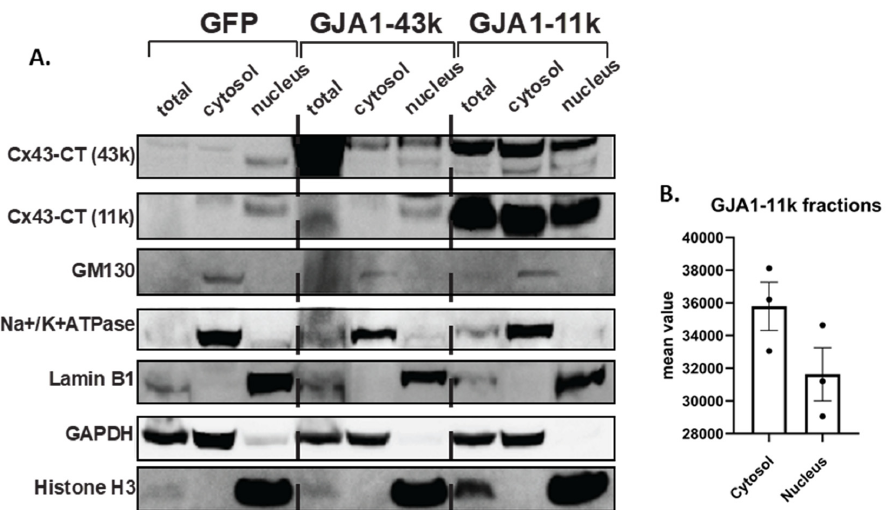
Figure 2. ( A ). Biochemical isolation of GJA1-11k in the nucleus. Western Blot of Cx43 isoforms in subcellular fractions (cytosolic and nuclear fractions) of HEK293FT cells over-expressing exogenous GJA1-11k, GJA1-43k, and GFP-V5 tagged plasmid cDNA, probed to monoclonal Cx43-CT (Millipore) antibodies. To demonstrate enriched biochemical isolation, the same blot was probed using antibodies to different subcellular fraction markers, including cytoplasmic (GAPDH), membrane (Na + /K + -ATPase), Golgi (GM-130), and nuclear markers (Histone H3, Lamin B1). The results are representative of three independent experiments. ( B ). The densitometry of CT-43k (11k) subcellular fractions assessed by Western Blot. Uncut immunoblots are provided in Figure S3.